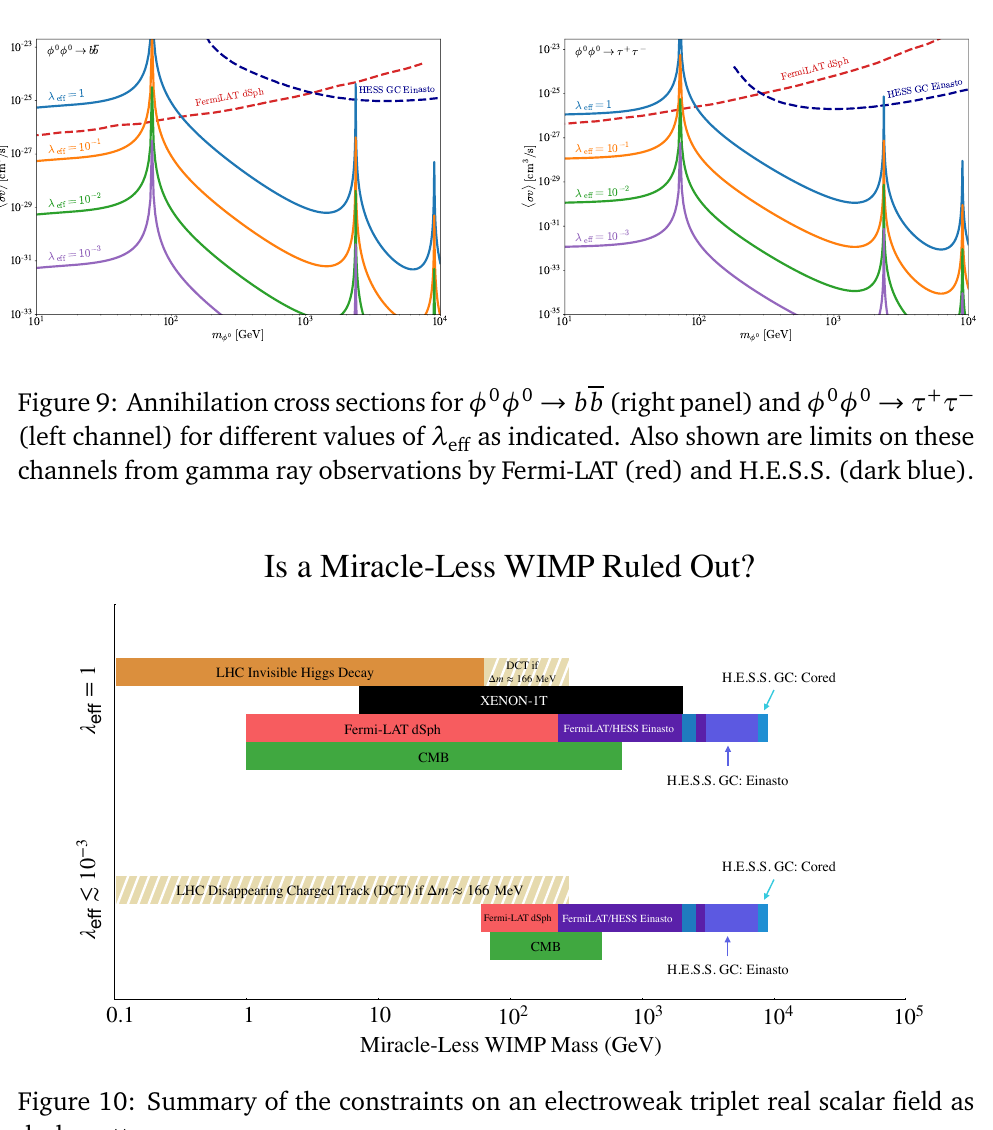
Figure 10: Summary of the constraints on an electroweak triplet real scalar field as dark